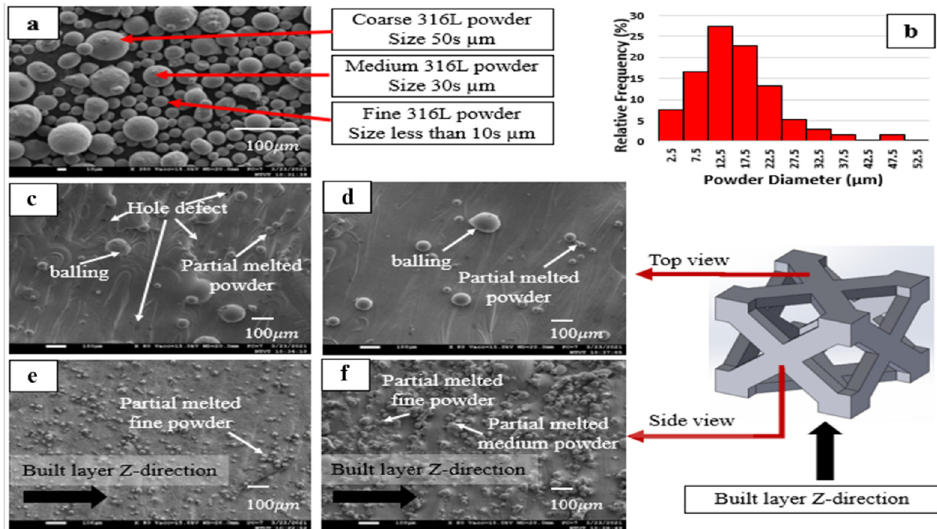
Figure 4. SEM images of ( a ) as-received powder, ( b ) powder size distribution, ( c ) top view of built object by laser energy density of 71 J/mm 3 , ( d ) 125 J/mm 3 , ( e ) side view of built object by laser energy density of 71 J/mm 3 , and ( f ) 125 J/mm 3.